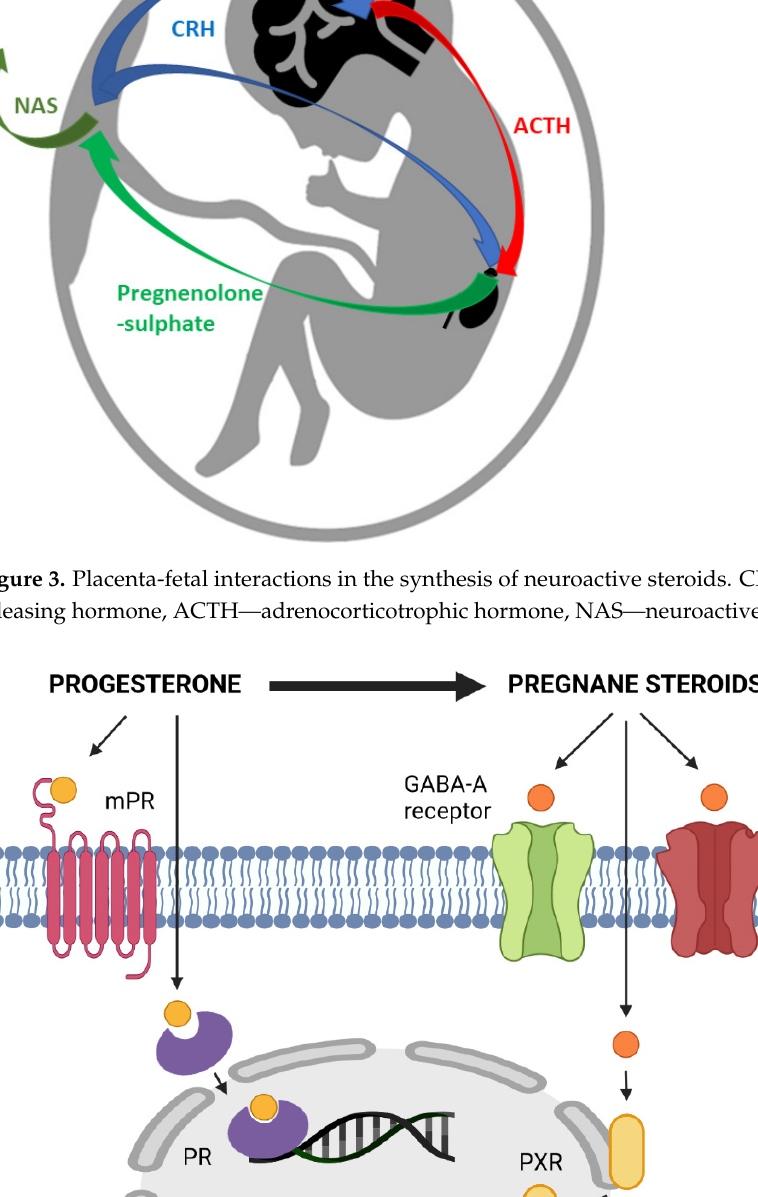
Figure 3. Placenta-fetal interactions in the synthesis of neuroactive steroids. CRH — corticotrophin- releasing hormone, ACTH — adrenocorticotrophic hormone, NAS — neuroactive steroids.